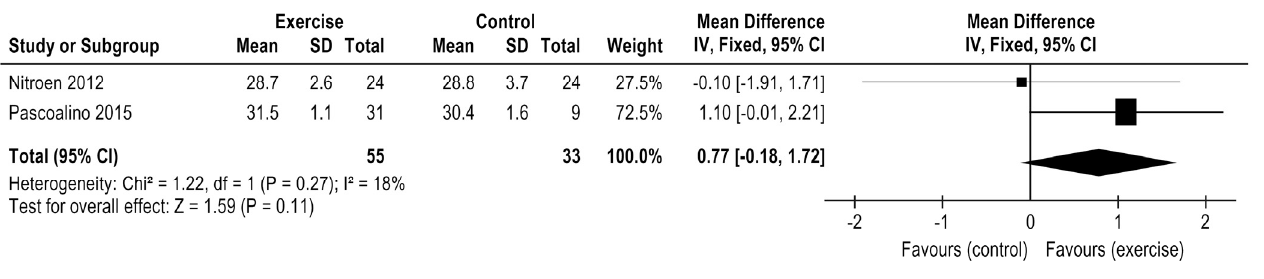
Figure 5. Impact of exercise training on VE/V’CO2 slope in HTx.